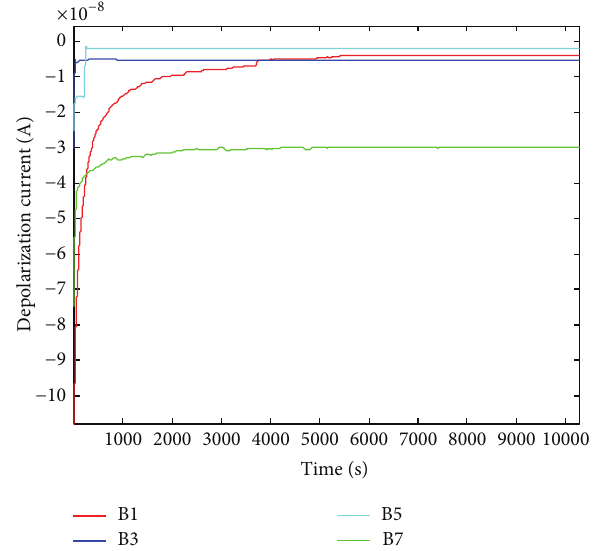
Figure 8: Depolarization current values for samples B1, B3, B5, and B7.